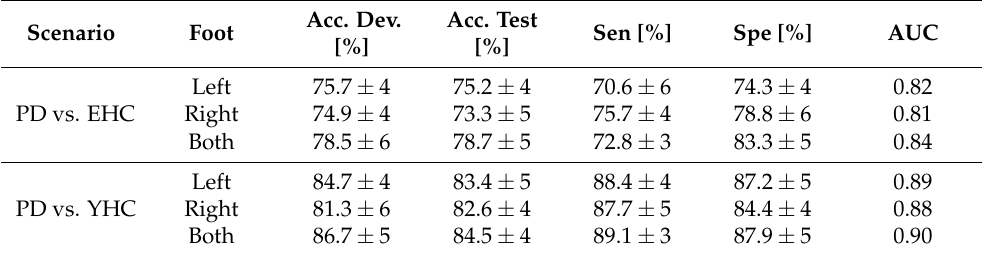
Figure 10. Methodology used for the classification with a GRU architecture and both feet. Table 4. Results using GRU and 2 × 10 m task.